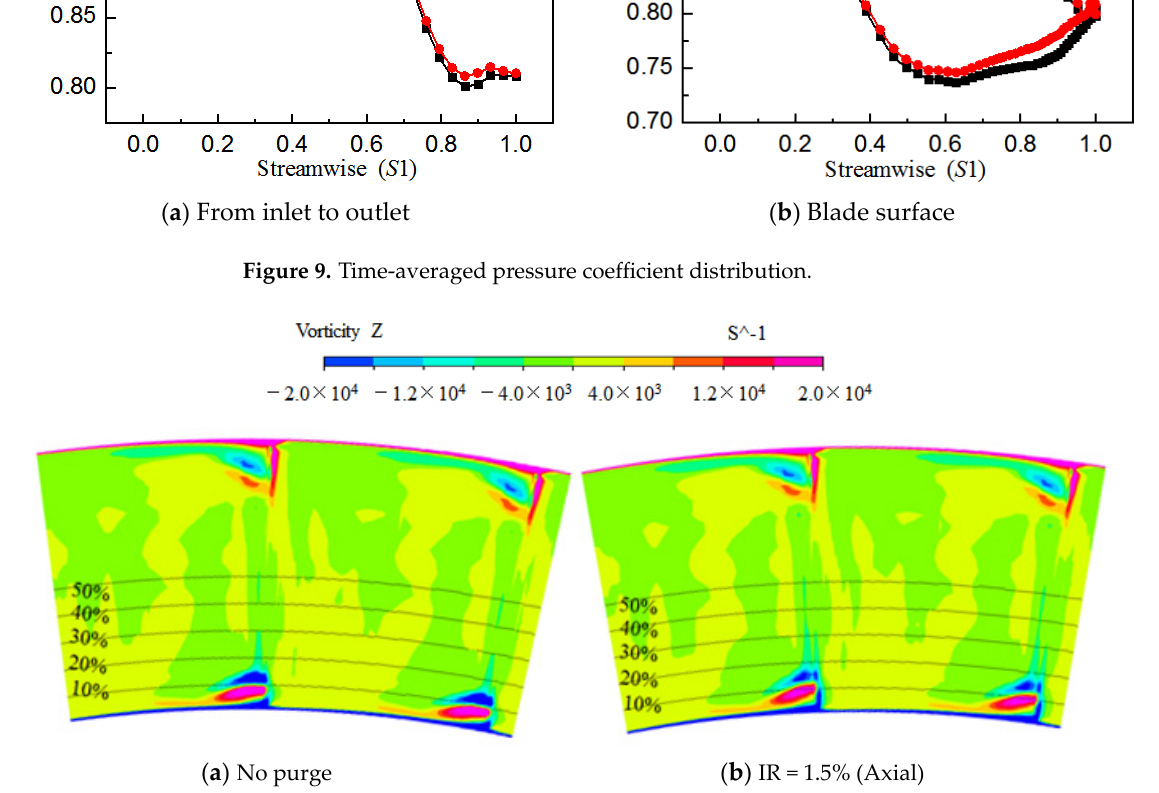
Figure 10. Time-averaged vorticity Z contour (streamwise 0.92).